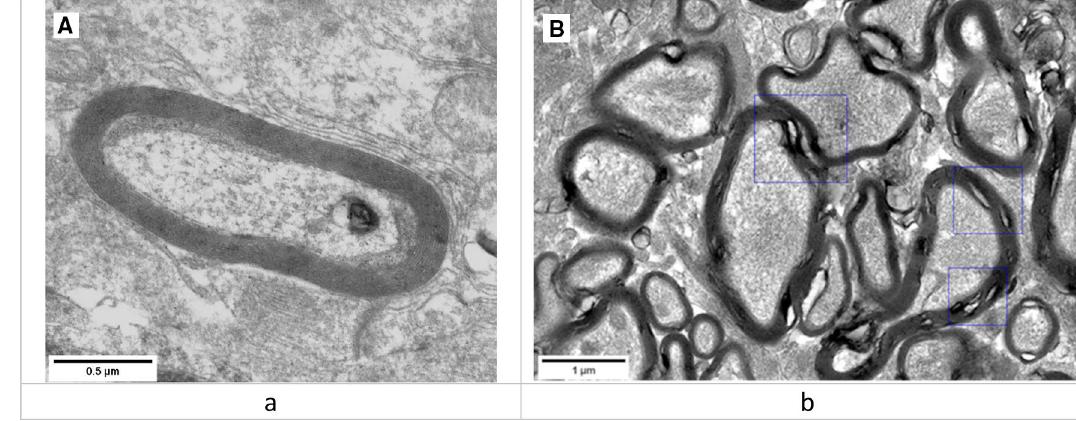
Figure 2. Representative STEM images of normal ( a ) and damaged ( b ) myelin morphotypes.